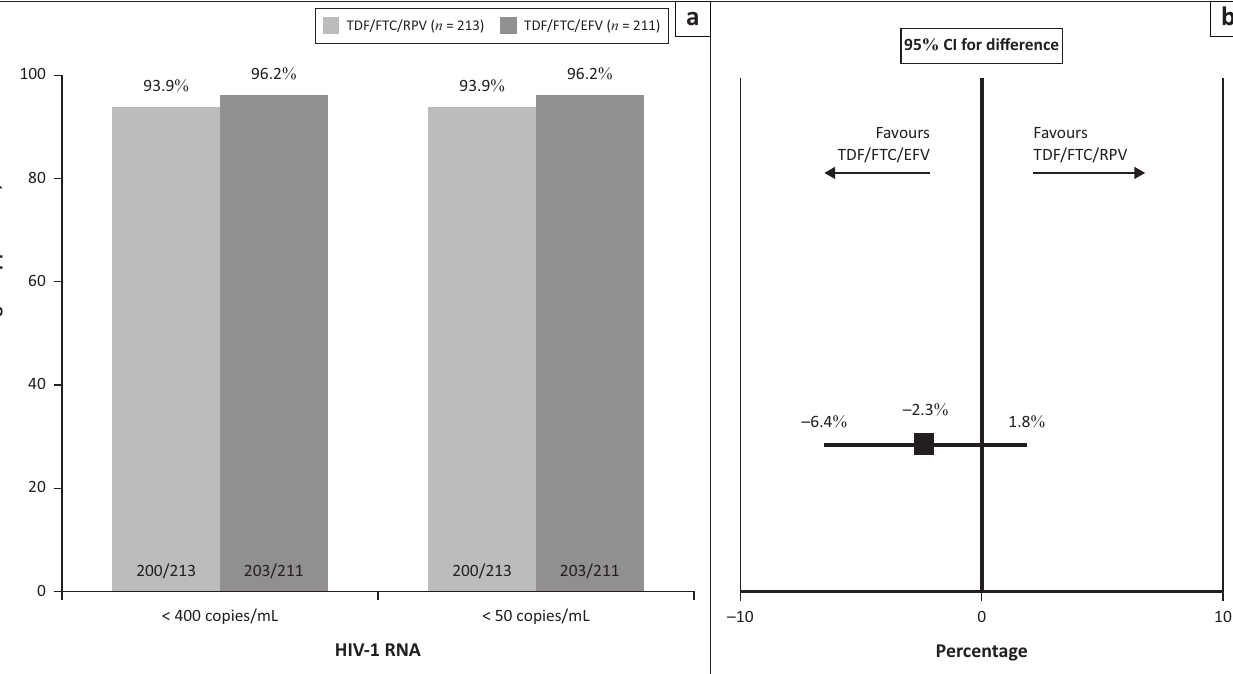
FIGURE 2: (a) Comparison of TDF/FTC/RPV and TDF/FTC/EFV showing a) % of patients with plasma HIV-1 RNA < 400 copies/mL (primary endpoint) and < 50 copies/mL at week 48 (ITT, modified FDA Snapshot analysis) and (b) difference in the primary endpoint between the two arms demonstrating